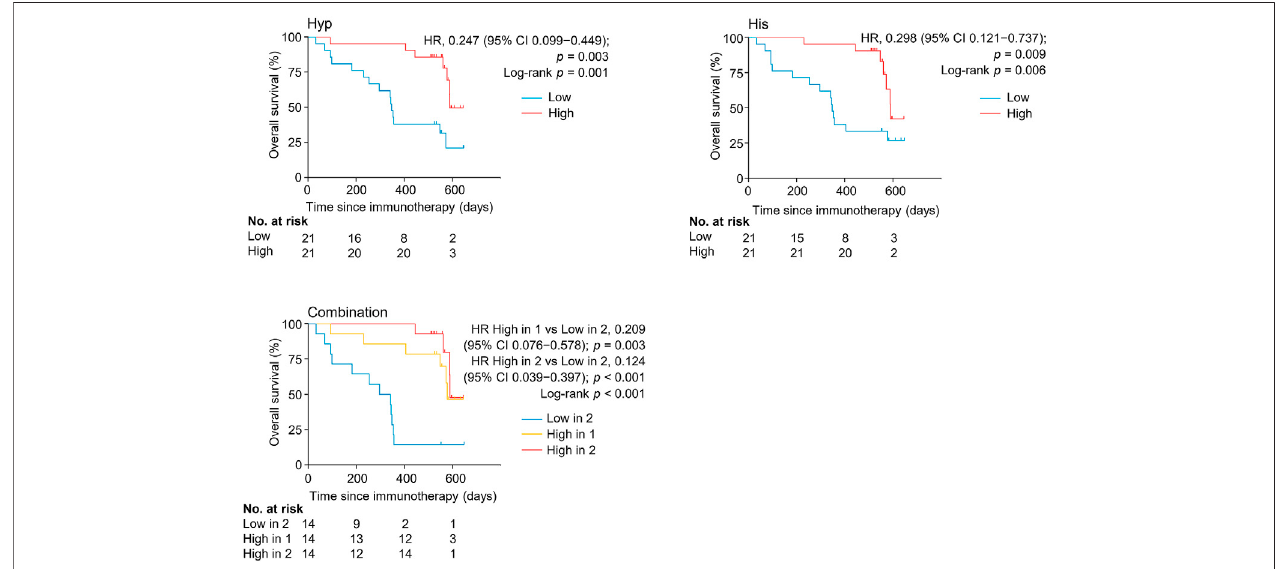
FIGURE 5 | Kaplan-Meier estimates of overall survival by serum levels of hypoxanthine and/or histidine in the discovery set. His, histidine; Hyp, hypoxanthine; HR, hazard ratio.